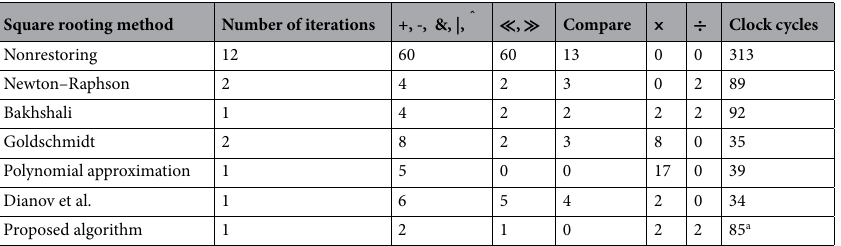
Table 4. Performance comparison of different square rooting methods based on the total number of clock cycles. a A single cycle is added for the latency of the lookup table.